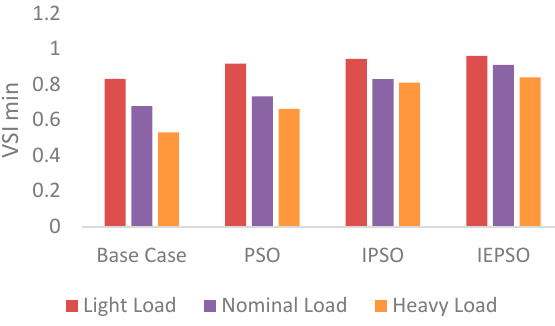
Figure 8. Voltage stability index for different load levels DNR in 69-bus test system.